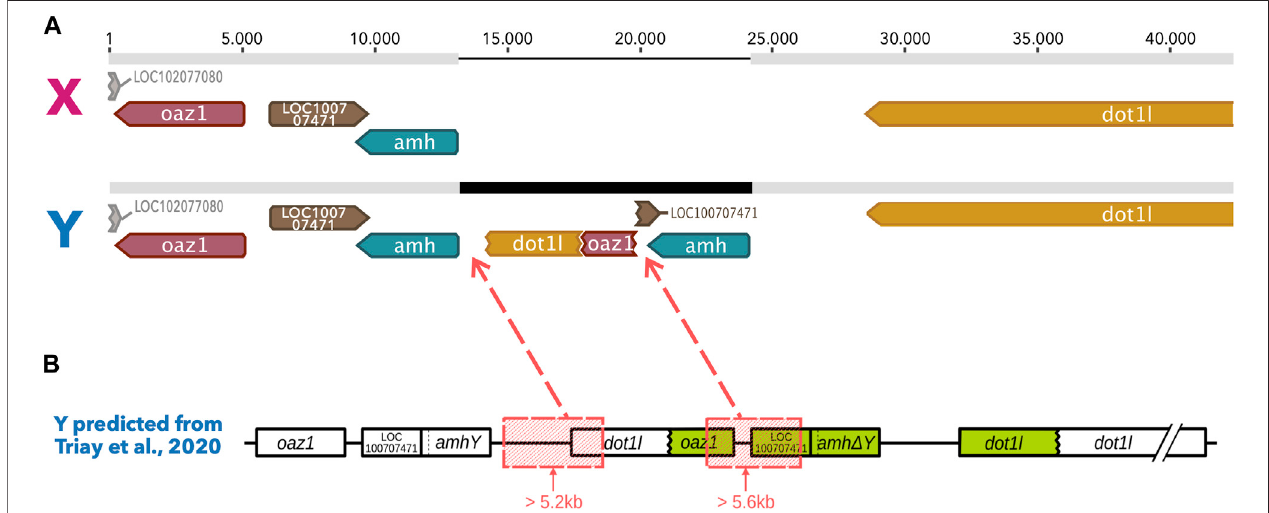
FIGURE 1 | Alignment of both the X haplotype and the Y predicted haplotype built according to the descriptions of the tandem duplication in Triay et al., 2020 . (A) GeneiousalignmentofboththeXhaplotypefromthereferencegenomeandtheYtheoreticalhaplotype.GreybarsrepresenthomologoussequencesbetweentheXand the Y haplotypes whereas the black region in the Y haplotype represents Y speci fi c regions that appeared due to a duplication of the dot1l , oaz1, LOC100707471 and amh genes. A chimera of the dot1l and oaz1 genes is seen as the result of large deletions that occurred after the duplication. The second copy of the amh gene however is well conserved in this inserted region. (B) Y haplotype prediction published in Triay et al. (2020) with the position of the large deleted regions (in red boxes) removed from the tandem duplication to build the Y of the